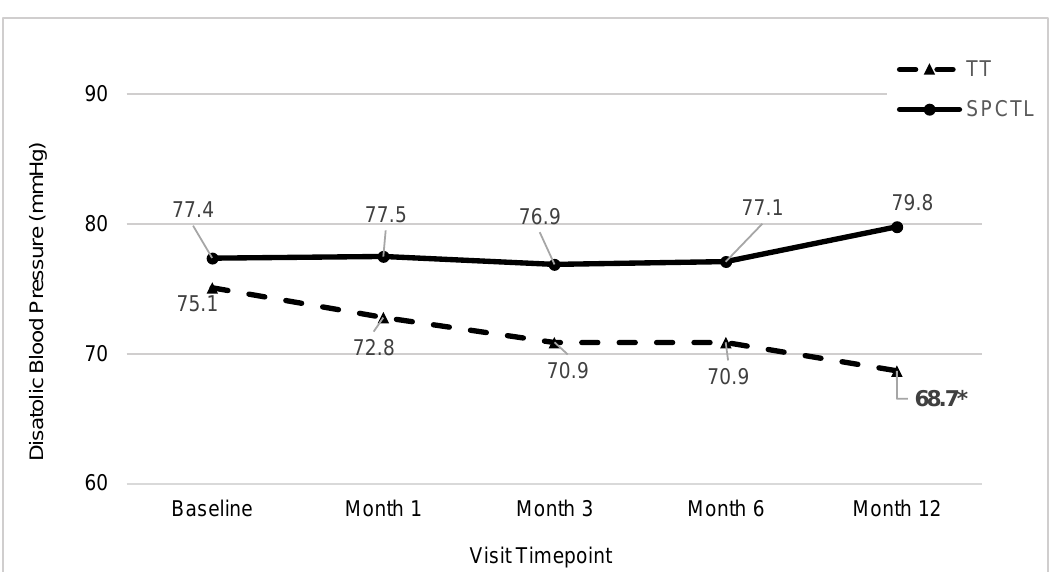
Figure 4. Average Diastolic Blood Pressure by Group and Visit.